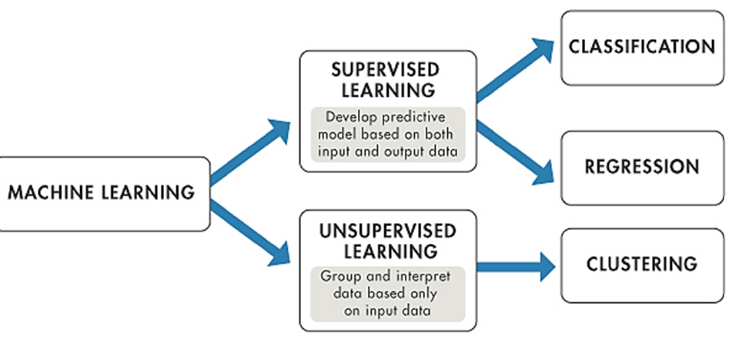
Figure 5. Machine learning dividing [10].